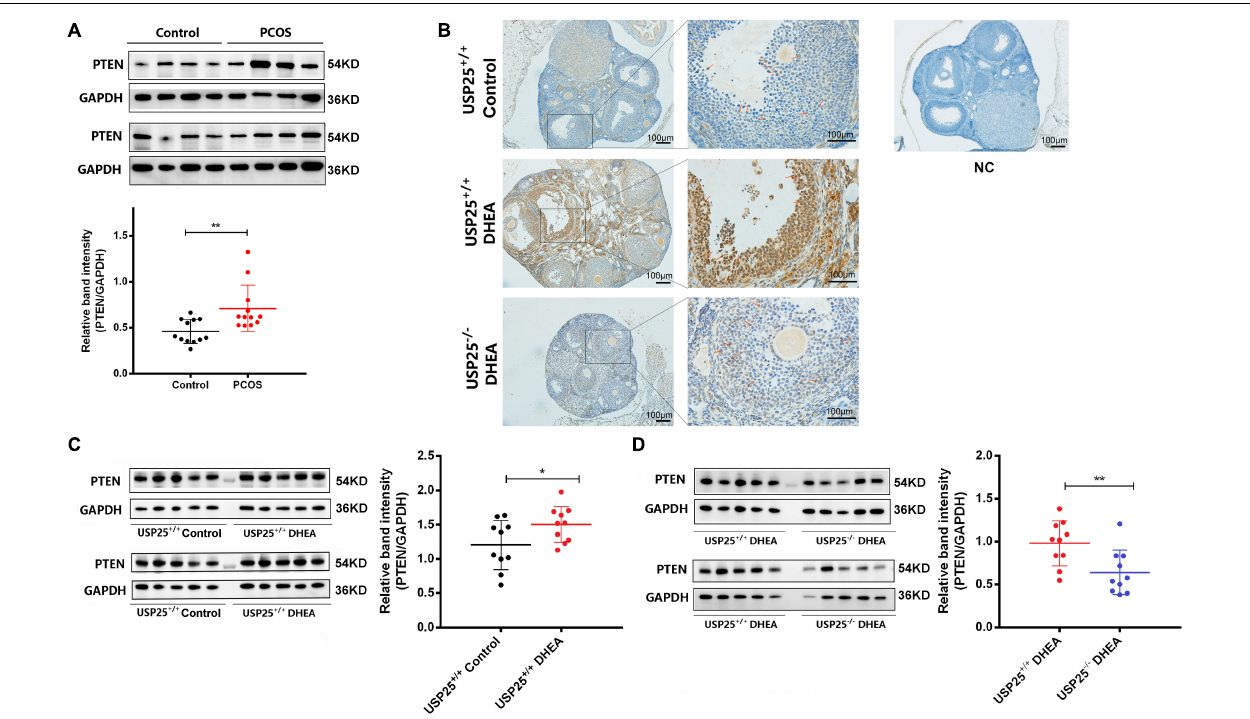
FIGURE 5 | The expression of PTEN in women and mice with PCOS. (A) PTEN protein was detected by Western blotting analysis in human luteinized GCs from patients in the control and PCOS groups ( n = 12 per group). The protein expression level of PTEN was statistically analyzed on the right. (B) Immunochemistry analysis of PTEN in the ovaries from the USP25 + / + control, USP25 + / + DHEA, and USP25 − / − DHEA groups. Bar = 100 µ m. NC, negative control. Some Positive staining of PTEN are indicated by red arrows. PTEN protein levels (C,D) were detected in the mouse ovaries from the four groups by Western blots. The quantification of protein levels is presented on the right. Data are expressed as the mean ± SD. The P -values were calculated by an unpaired two-tailed Student’s t -test compared with the controls. * P < 0.05, ** P <